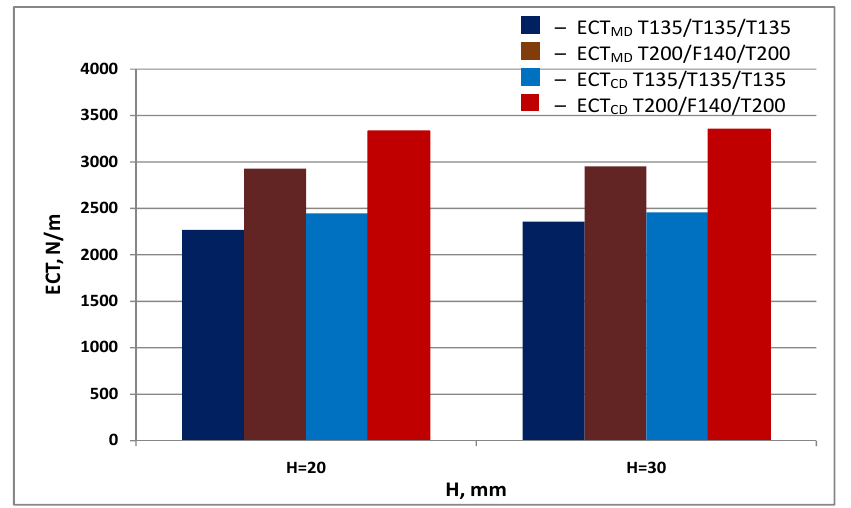
Figure 10. Results of ECT MD measurements of cardboard with a 15 mm mesh diameter, made of various raw materials.